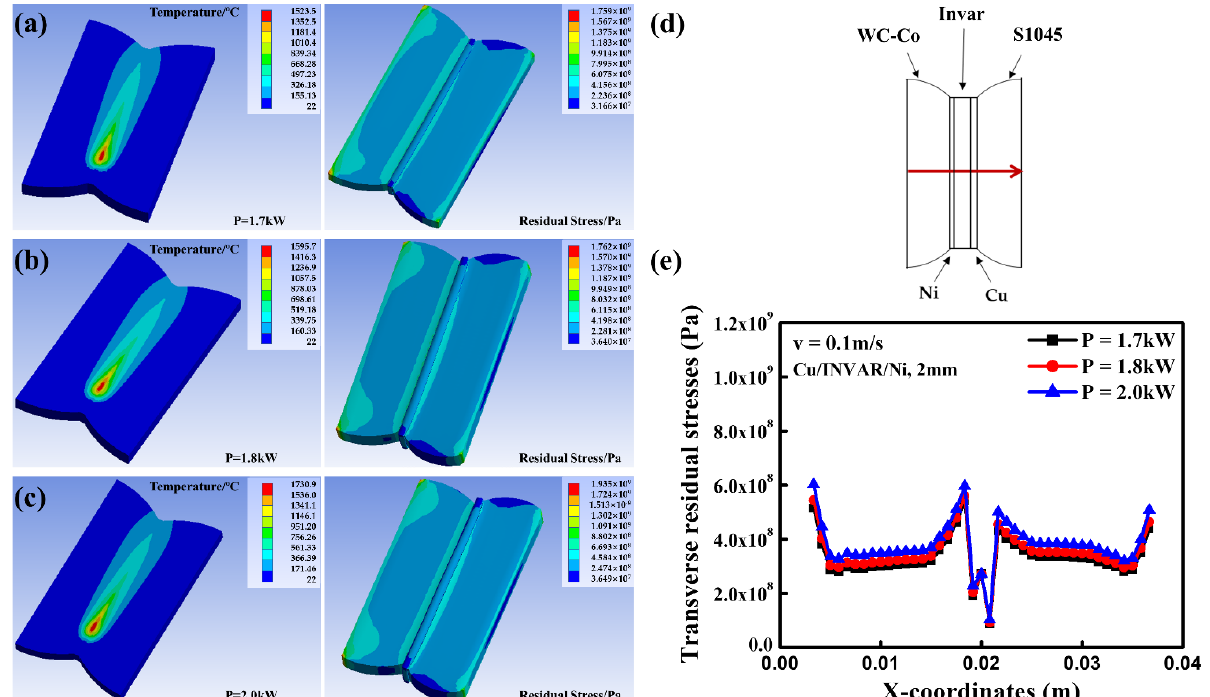
Figure 14. Simulation results of temperature field and residual stress field when laser power of as-welded joint is equal to: ( a ) 1.7 kW, ( b ) 1.8 kW, ( c ) 2.0 kW, ( d ) Schematic diagram of residual stress simulation, ( e ) Comparison curve of residual stresses at different laser power.